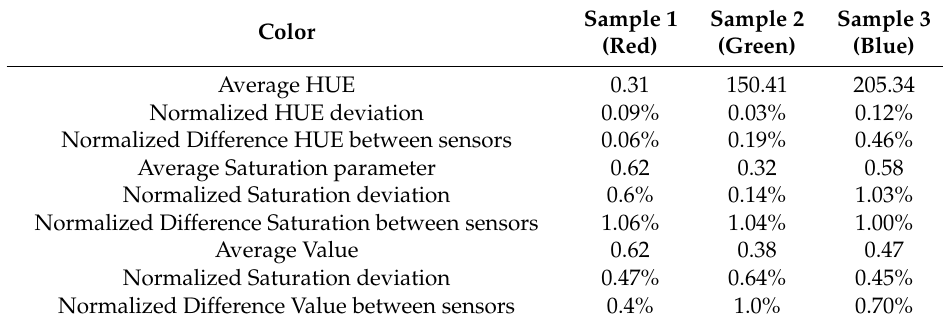
Table 2. Repeatability of the measured HSV parameters of three color samples.